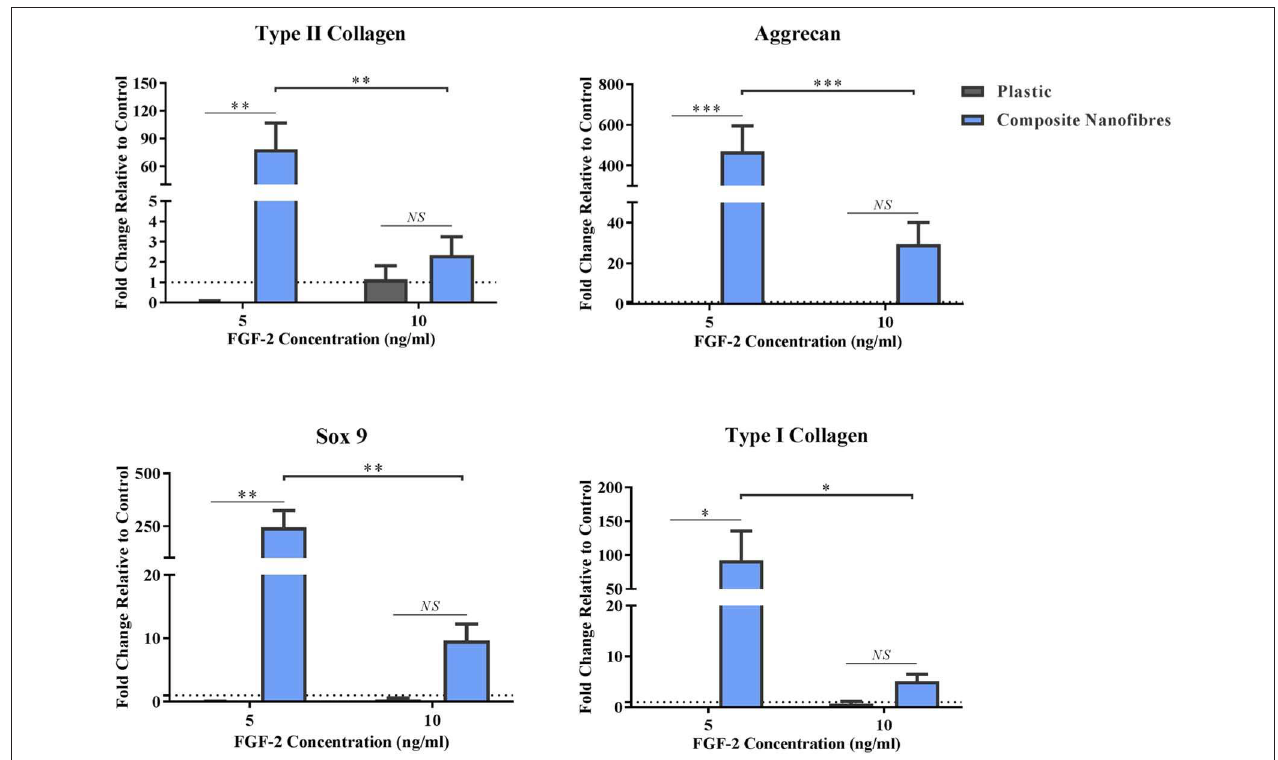
FIGURE 3 | Stimulative capacity of composite nanofibrous mats. hMSCs were cultured on plastic and composite nanofibres in the absence of soluble chondrogenic factors. Following 14 days culture, qPCR was performed to quantify the level of chondrogenic gene expression—Col2, Agg, and Sox-9—as well as Col1. Gene expression levels were normalized to the expression of the housekeeping gene. GAPDH (shown in dotted line). Graph shows mean ± SE. Samples were compared statistically using two-way ANOVA with Bonferroni post-test . * p < 0.05, ** p < 0.01, *** p < 0.001, n =